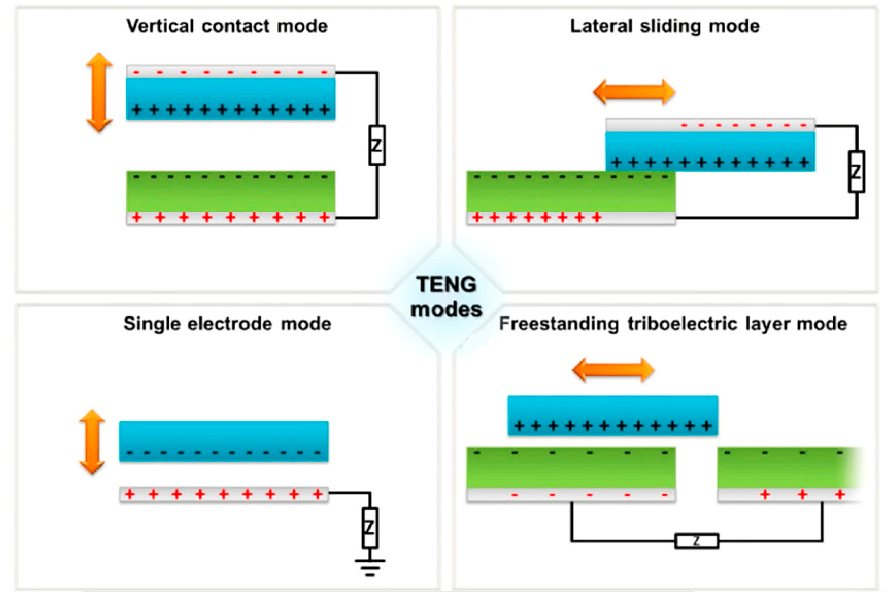
Figure 11. The four fundamental modes of TENGs: vertical contact mode, lateral sliding mode, single electrode mode, and free-standing triboelectric layer mode [48].